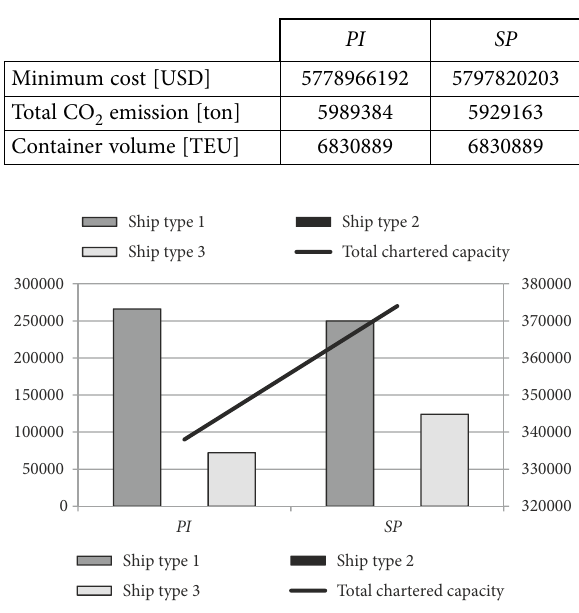
Figure 2. Chartering capacity